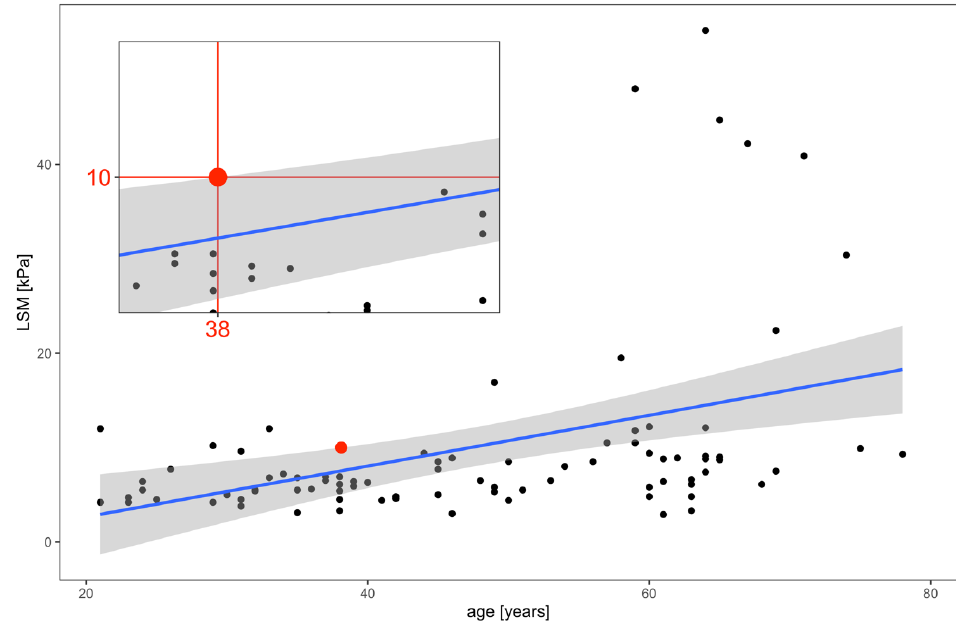
Figure 3. Correlation of LSM and age. Advanced liver fibrosis is unlikely in individuals younger than 38.1 years. The blue line represents the linear regression model of the correlation between LSM and age. The black points represent the individual patients. The red point represents the cut-off value with the 95% certainty that individuals younger than 38.1 years do not have LSM > 10 kPa. The confidence intervals are in grey. LSM, liver stiffness measurement.